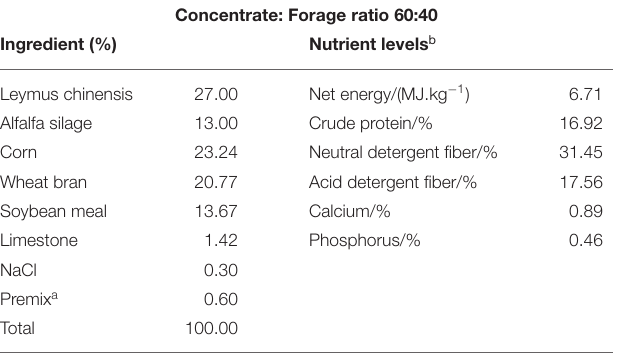
TABLE 1 | Ingredients and nutritional composition of the diets.